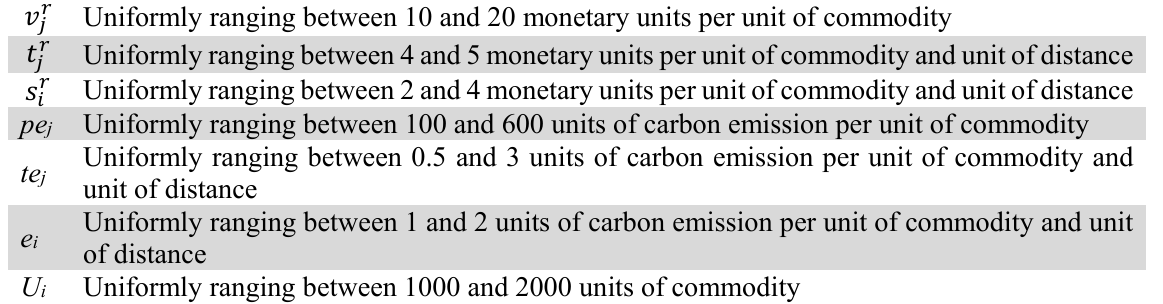
Values of other